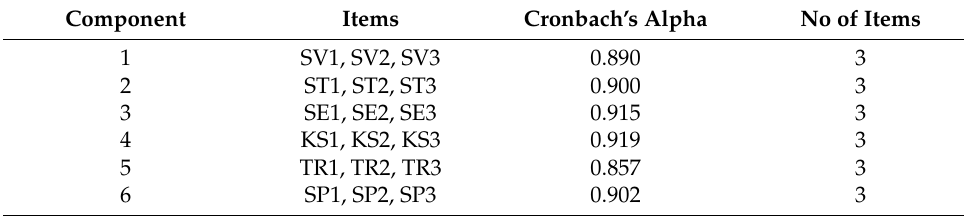
Table 3. The Cronbach’s alpha coefficient values.